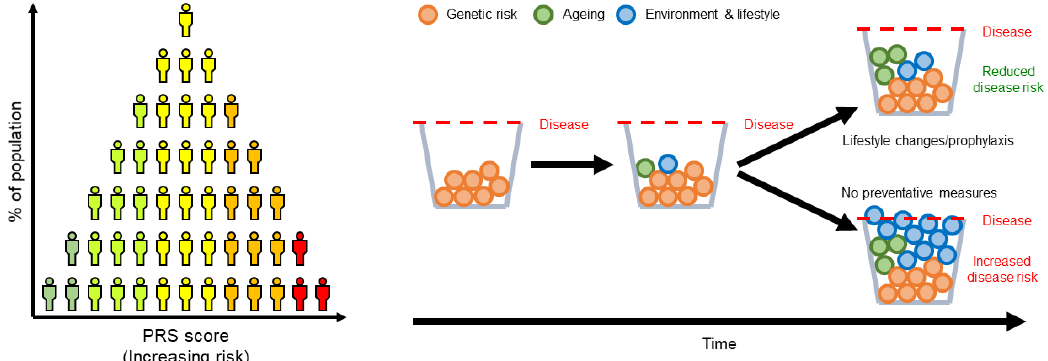
Figure 1. Polygenic risk scores based on the weighted sum of genetic variants can be used to estimate an individual’s predisposition to complex polygenic disorders such as Parkinson’s disease (PD), and allow those at greatest risk in the population to be identified (left). Those at risk can be recommended lifestyle changes or preventative treatments that may combat their increased likelihood of developing a disease (right).